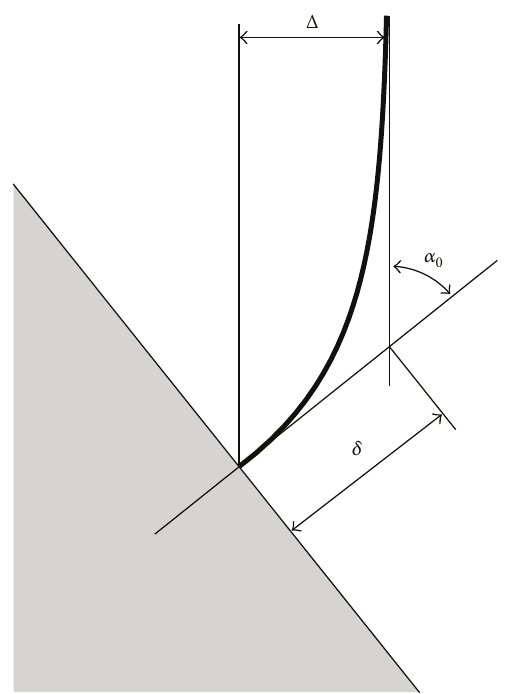
Figure 5: Schematic representation of the virtual suspension point